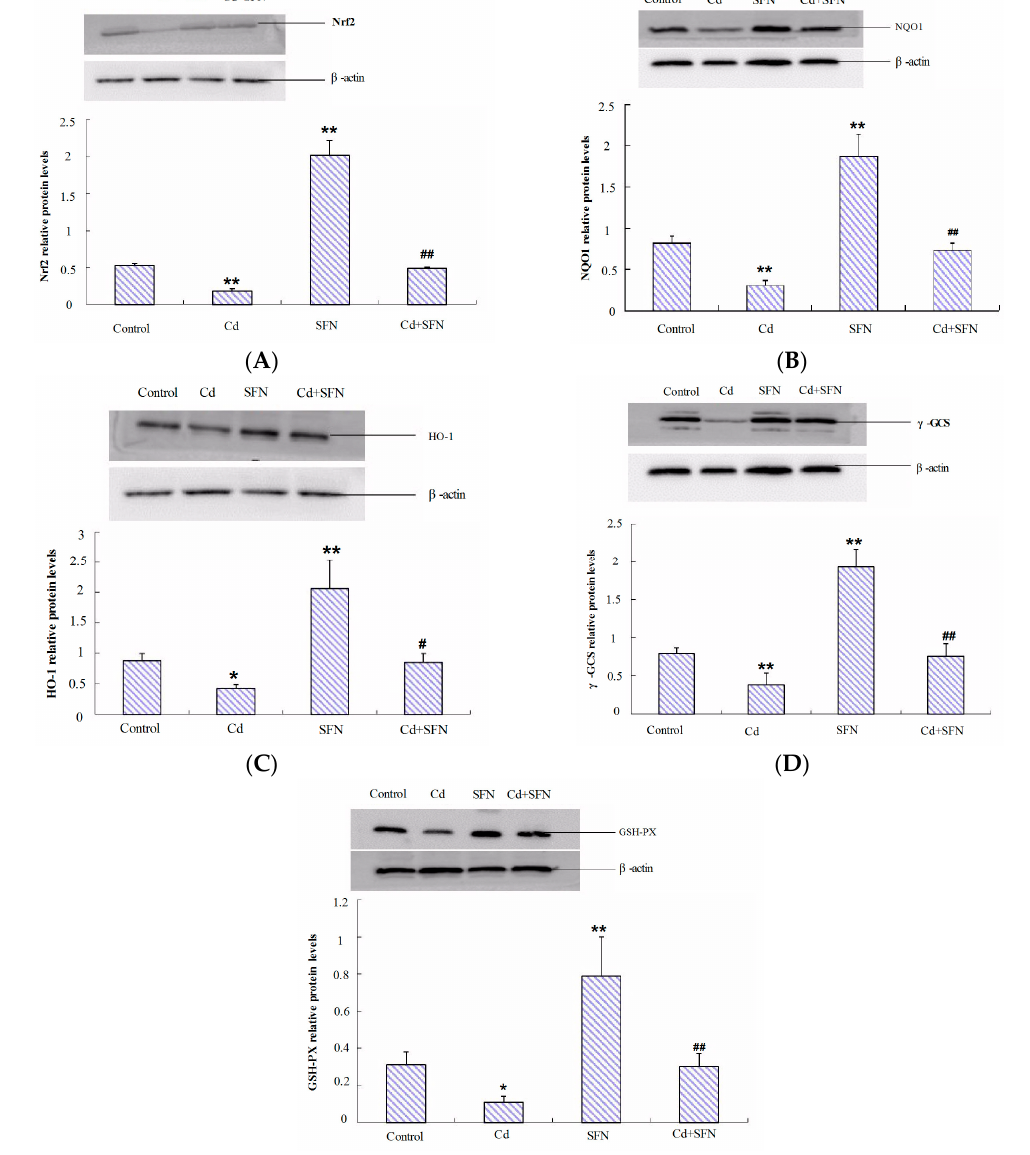
Figure 5. SFN pretreatment and cadmium-induced Nrf2/ARE (antioxidant response element) signaling in mouse testes. ( A ) Nuclear factor-erythroid 2-related factor 2 (Nrf2); ( B ) NAD(P)H:quinone oxidoreductase 1 (NQO1); ( C ) hemeoxygenase-1 (HO-1); ( D ) γ -glutamyl cysteine synthetase ( γ -GCS); and ( E ) glutathione peroxidase (GSH-Px). Values represent mean ± SEM in each group of 10 mice; * p < 0.05, ** p < 0.01 vs. control; # p < 0.05, ## p < 0.01 vs. cadmium group.